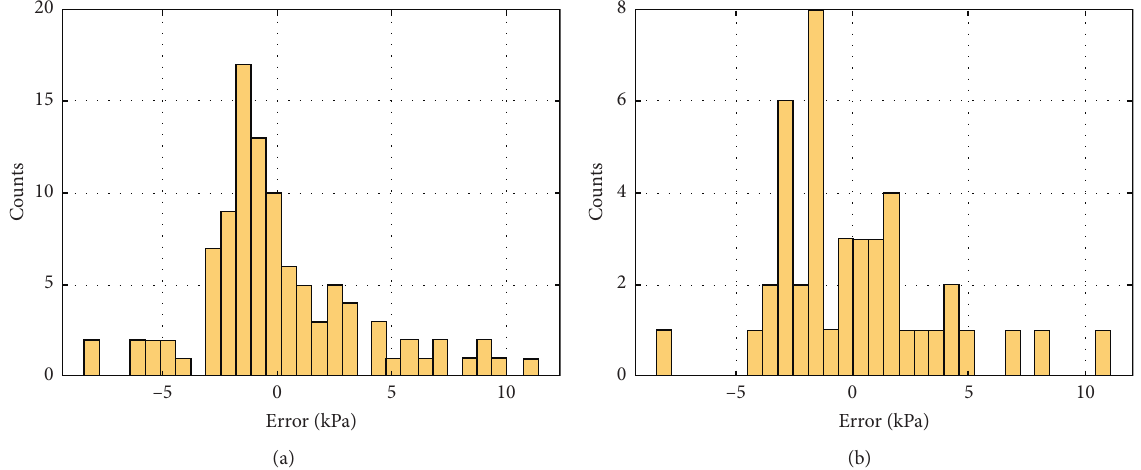
Figure 7: Error histogram analysis of RF using (a) training dataset and (b) testing dataset.